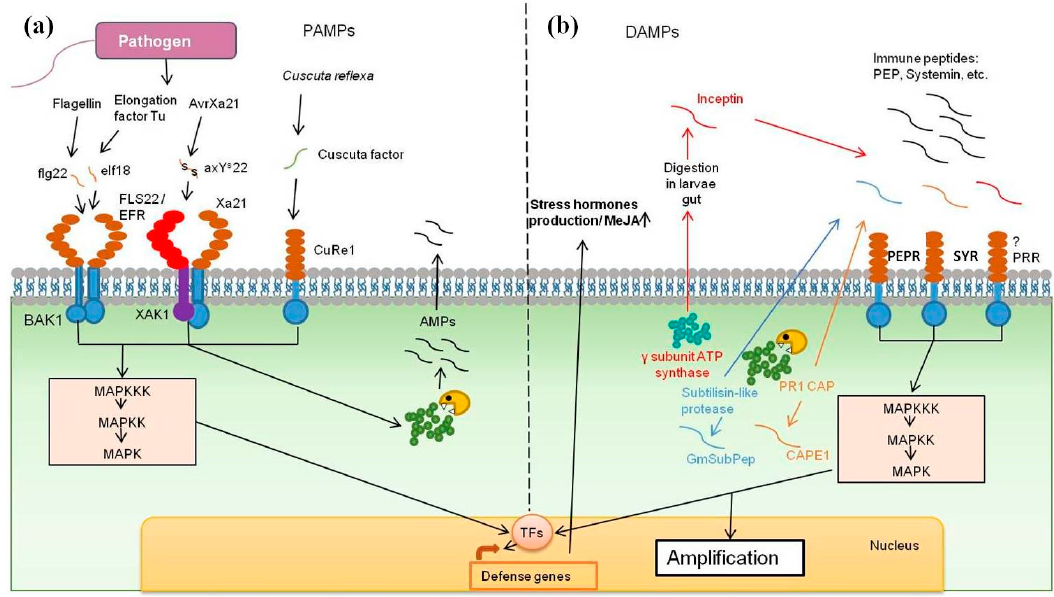
Figure 1. Peptide signals hidden in ( a ) pathogenic and ( b ) host plant proteins. Table 1. Cryptic immune signals.